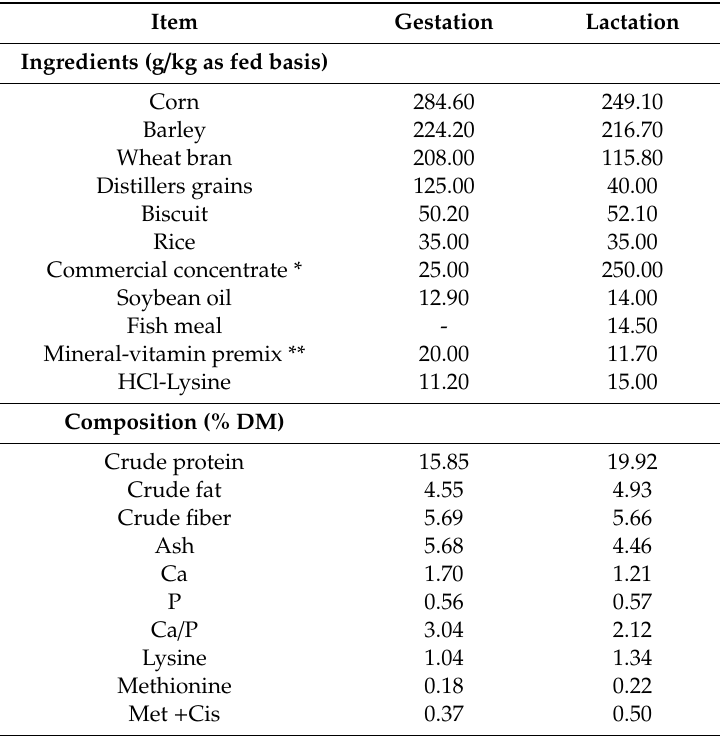
Table 1. Composition of Basal Sow Diets.